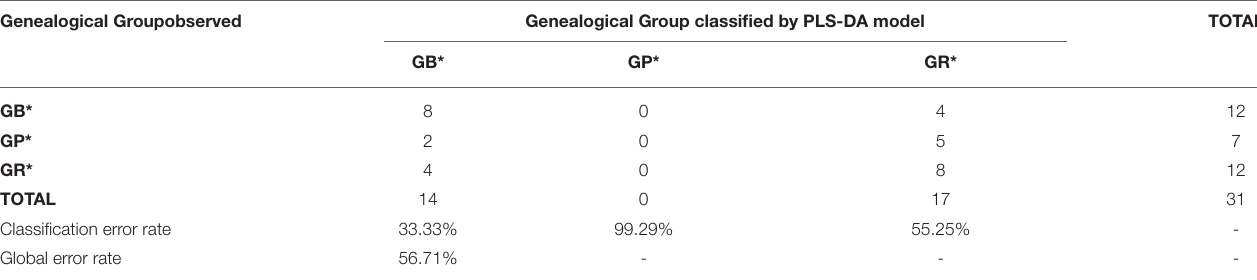
TABLE 3 | Counting false positives and negatives in reference to the classification of genealogical groups by the PLS-DA model and their respective error rates obtained through a cross-validation procedure using 5 parts (5-fold) of the data set to adjust the model and the rest to test the same in 100 simulations. Genealogical Groupobserved Genealogical Group classified by PLS-DA model